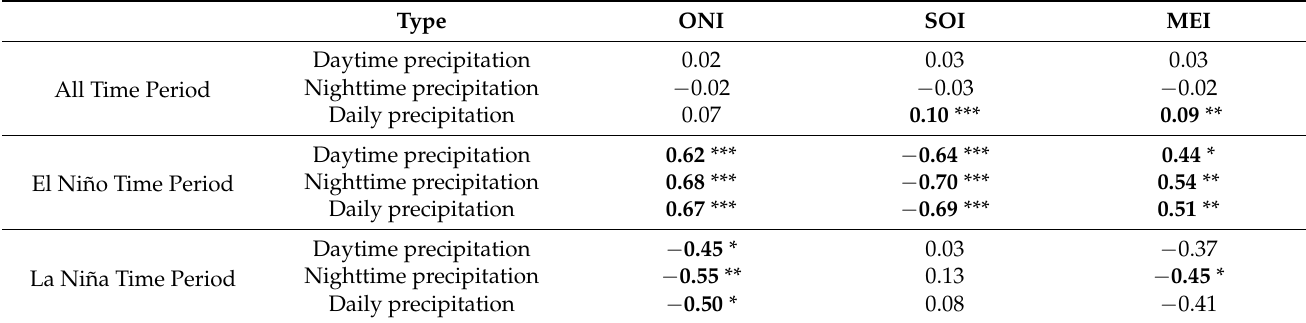
Table 4. Correlation matrix of diurnal precipitation and ENSO indices in different